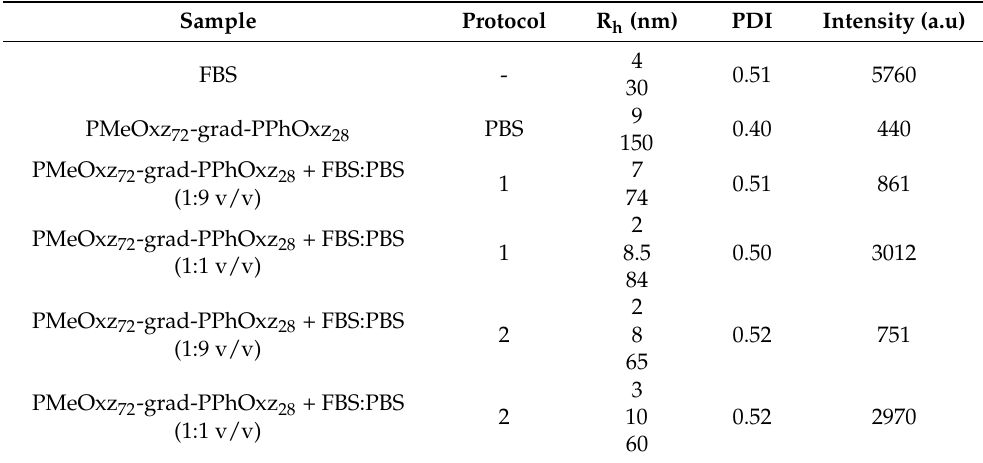
Table 3. Physicochemical characteristics of bare FBS, PMeOxz 72 -grad-PPhOxz 28 GC and protein-GC mixtures obtained from DLS measurements based on the protocol used for their preparation. Data for R h denote multiple peaks.